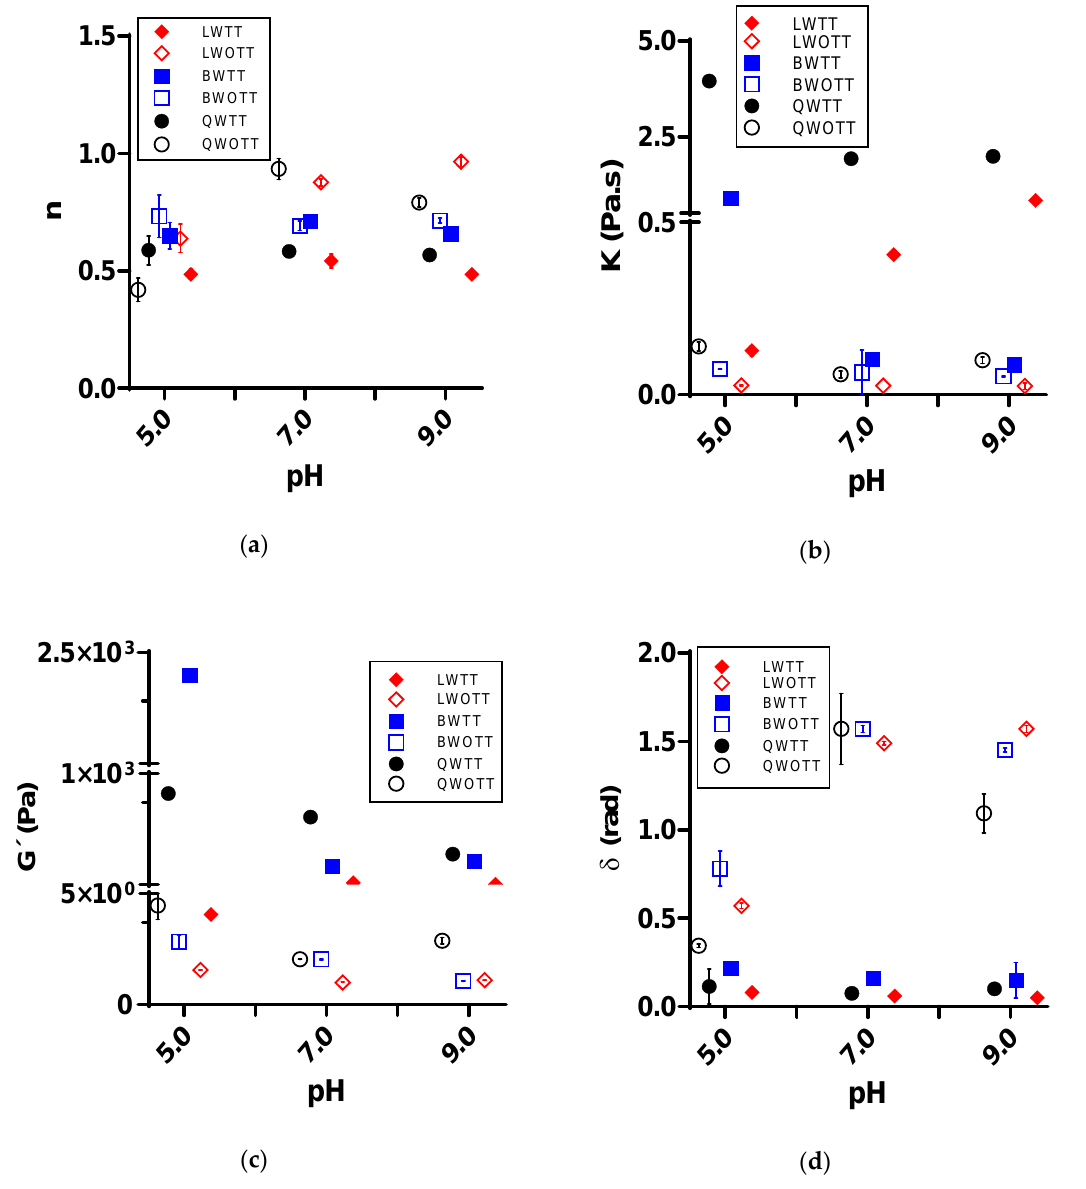
Figure 2. Effect of pH change and thermal treatment on the rheological properties of solutions prepared with quinoa protein concentrates with heat treatment (QWTT) and without heat treatment (QWOTT); black bean protein concentrates with heat treatment (BWTT) and without heat treatment (BWOTT); and lentil protein concentrates with heat treatment (LWTT) and without heat treatment (LWOTT). ( a ) Average flow behavior ( n ) of the solutions; ( b ) average consistency index (K) of solutions; ( c ) average storage module (G’) of the frequency sweeps; ( d ) average phase shift angle (δ) of the frequency sweeps.